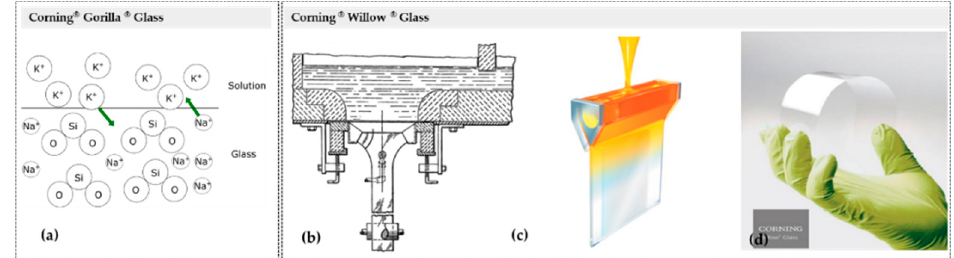
Figure 1. Corning ® keeps leading innovation in high-tech glass materials: ( a ) Corning ® Gorilla ® Glass fabrication technic; ( b – d ) Corning ® Willow ® Glass, b—down-draw fabrication process, c—overflow fabrication process, and d—Flexible Corning ® Willow ® Glass product. (b—reprinted from [14] © (2010) with permission from Wiley; c—reprinted (adapted) with permission from [15] © (2016) American Chemical Society; d—reprinted from [16] © 2021 with permission from Wiley).